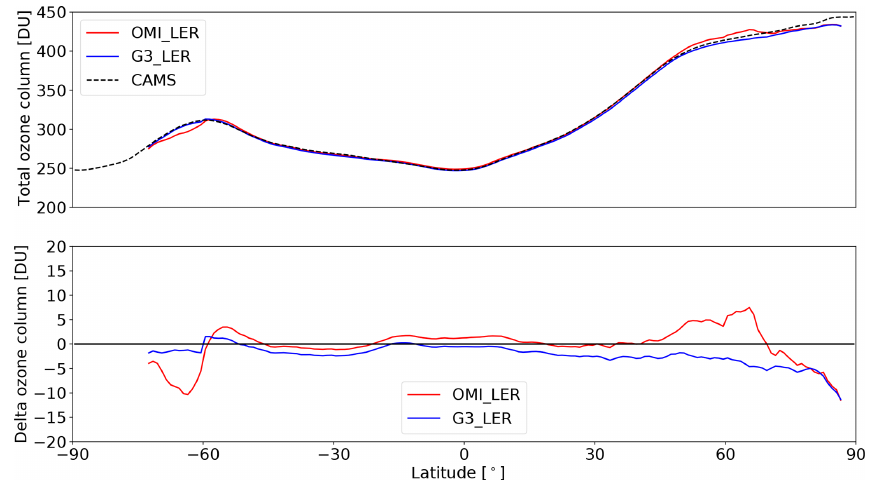
Figure 13. Comparison of total ozone from CAMS and the S5P retrieved ozone using the OMI LER climatology and the daily TROPOMI G3_LER maps for April 2018. Total ozone values based on daily G3_LER maps are significantly closer to those from CAMS especially for high-latitude regions. Table 3. Latitudinal differences between total ozone from CAMS and S5P using TROPOMI G3_LER and OMI LER for the month of April 2018. The values represent the total number of measurements for each latitudinal range and the mean differences ± standard deviations (in percentages). Latitude bands with less than 100000 data points were skipped, due to polar winter conditions; there are hardly any data south of 81 ◦ S. The number of measurements increases towards higher north because of overlapping